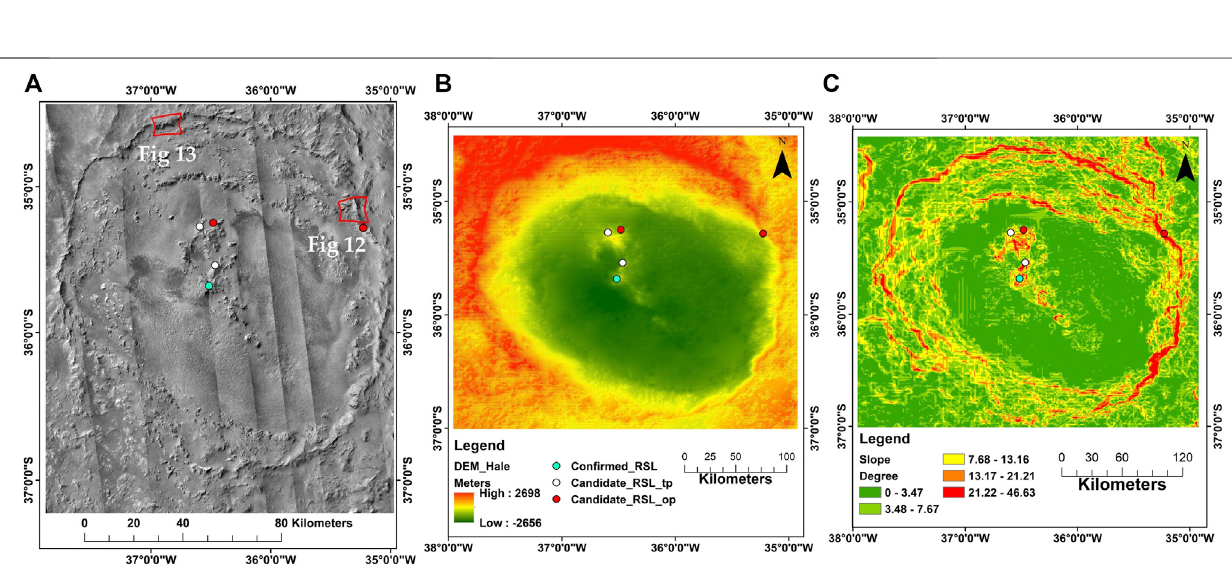
Frontiers in Astronomy and Space Sciences |